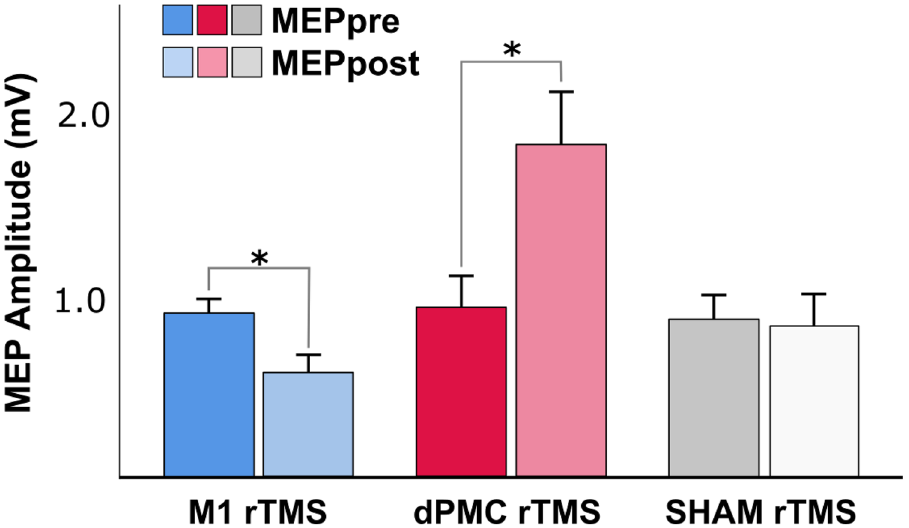
Figure 2. 1 Hz rTMS-induced effects on corticospinal excitability. Mean amplitudes of 20 motor evoked potentials (MEPs) before the training session (MEPpre) and immediately after (MEPpost) 20 min of post- training 1 Hz rTMS of the primary motor cortex (M1 rTMS), the dorsal premotor cortex (dPMC rTMS), or sham rTMS. Error bars indicate the standard error of the mean. The asterisks indicate significant